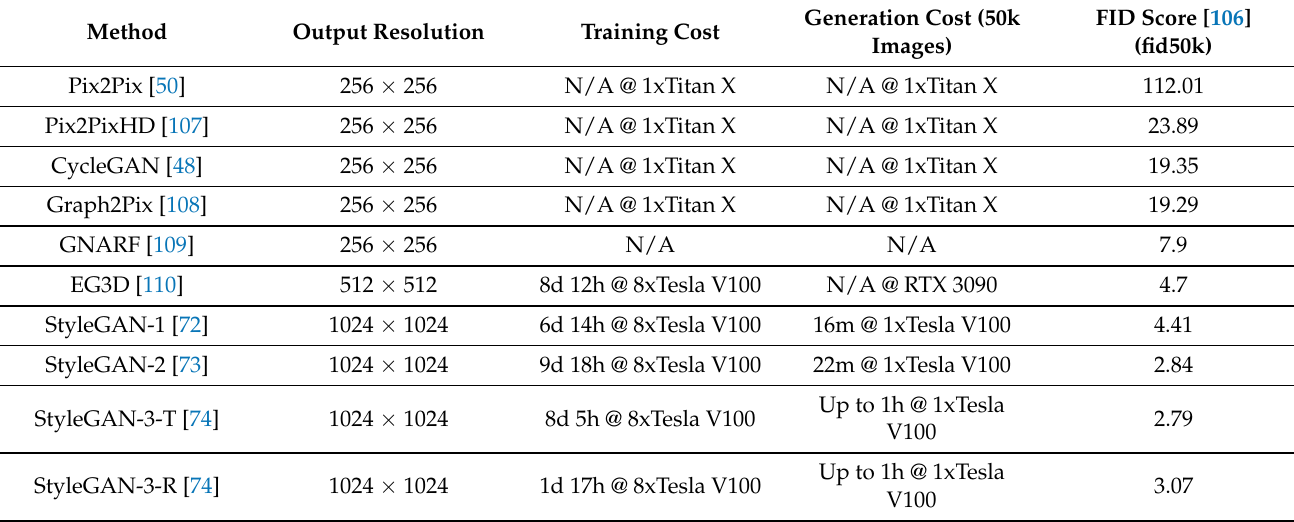
Table 1. Performance of different data synthesis methods for face synthesis, the lower the FID score the